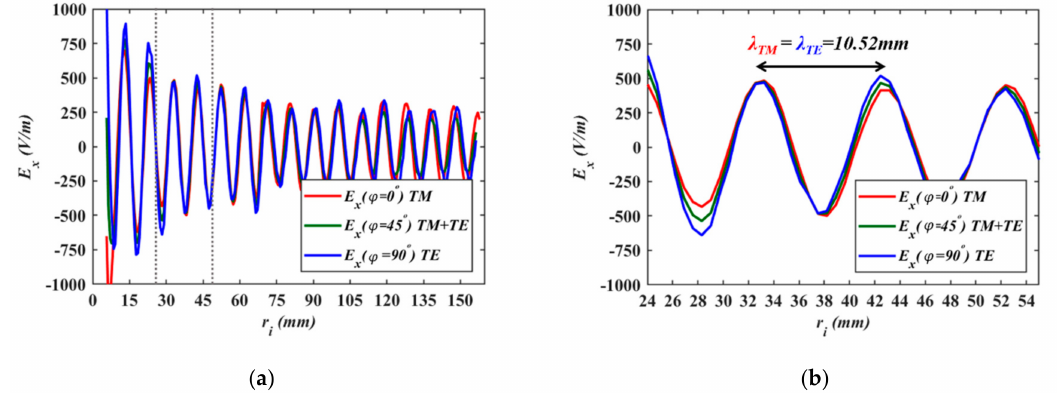
Figure 8. ( a ) Re(E x ) field in the aperture ( R = 50 u = 157 mm) at ϕ = 0 ◦ , 45 ◦ , 90 ◦ as a combination of the TM and TE SW fields; ( b ) Zoom of the